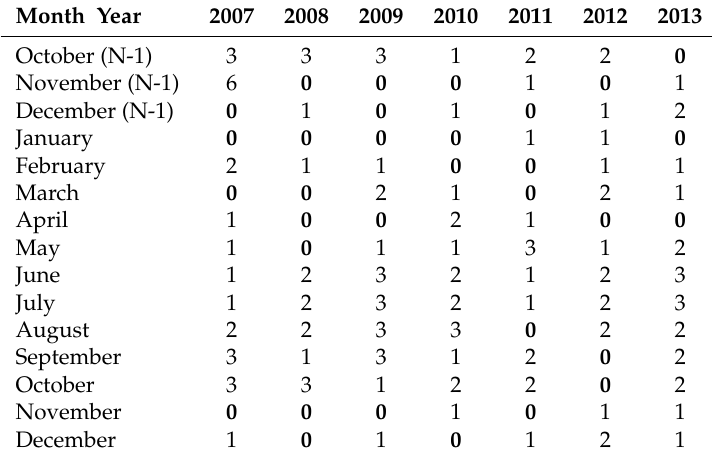
Table 1. Number of available images per month for all the used periods. 0 represents a lack of images, either due to clouds or technical